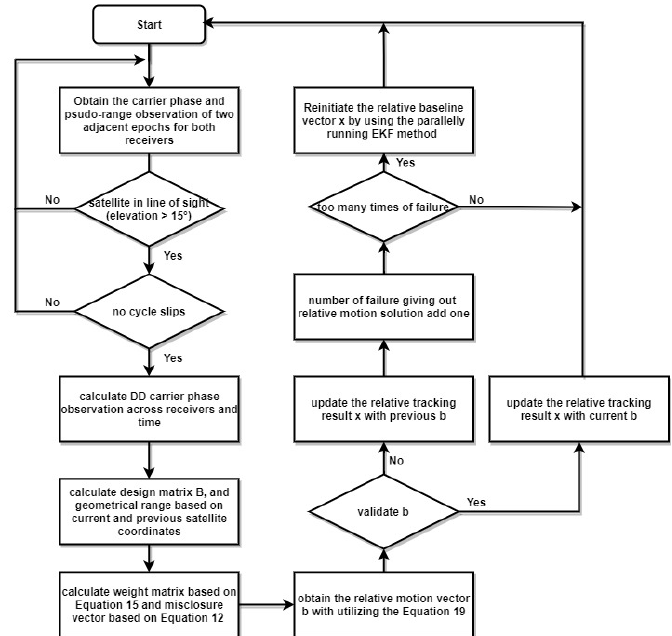
Figure 2. The whole procedure of the M-Regtrack